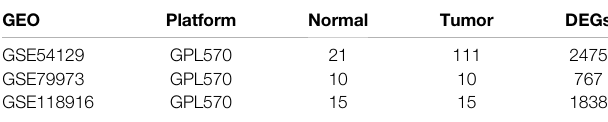
TABLE 1 | The GEO gene expression datasets description. GEO